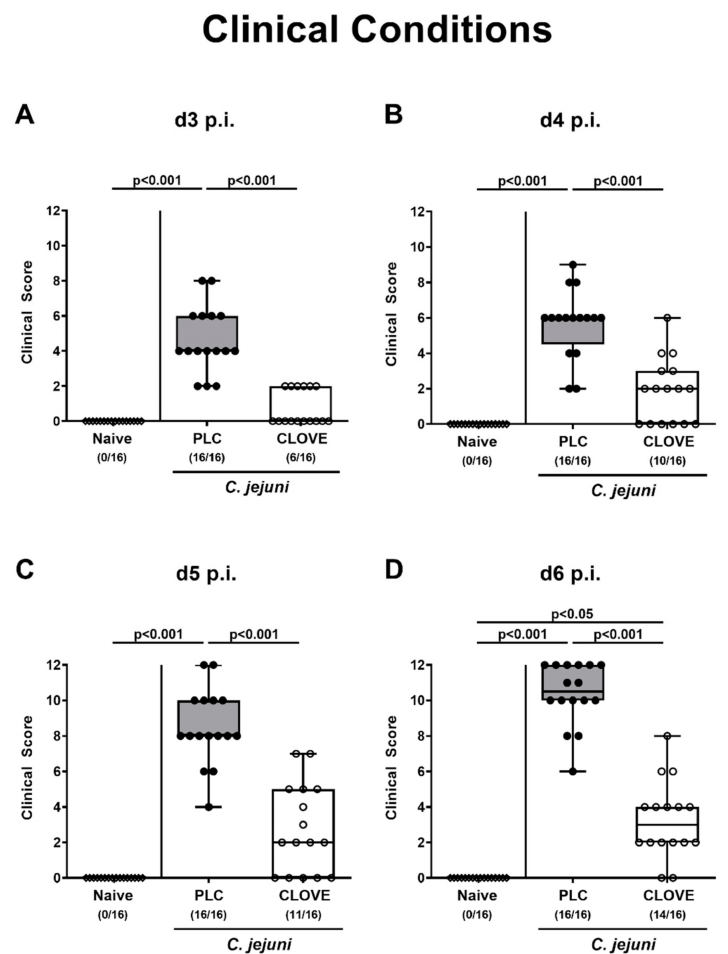
Figure 3. Kinetic survey of C. jejuni induced clinical conditions following clove EO treatment of infected IL-10 − / − mice. Microbiota-depleted IL-10 − / − mice were perorally infected with C. jejuni strain 81-176 on day (d) 0 and d1. From d2 until d6 post-infection (p.i.), mice were perorally challenged with clove EO or received placebo (PLC) via drinking water. The clinical conditions of mice were quantitatively determined over time, i.e., on ( A ) d3, ( B ) d4, ( C ) d5 and ( D ) d6 p.i. by using a clinical scoring system by using a clinical scoring system. Box plots indicate the 75th and the 25th percentiles of the median (black bar within box). Naive mice were included as negative control animals. The total range, significance levels ( p values) determined by the Kruskal-Wallis test and Dunn’s post-correction and the number of mice with clinical signs out of the total number of analyzed animals (in parentheses) are given. Data were pooled from four independent